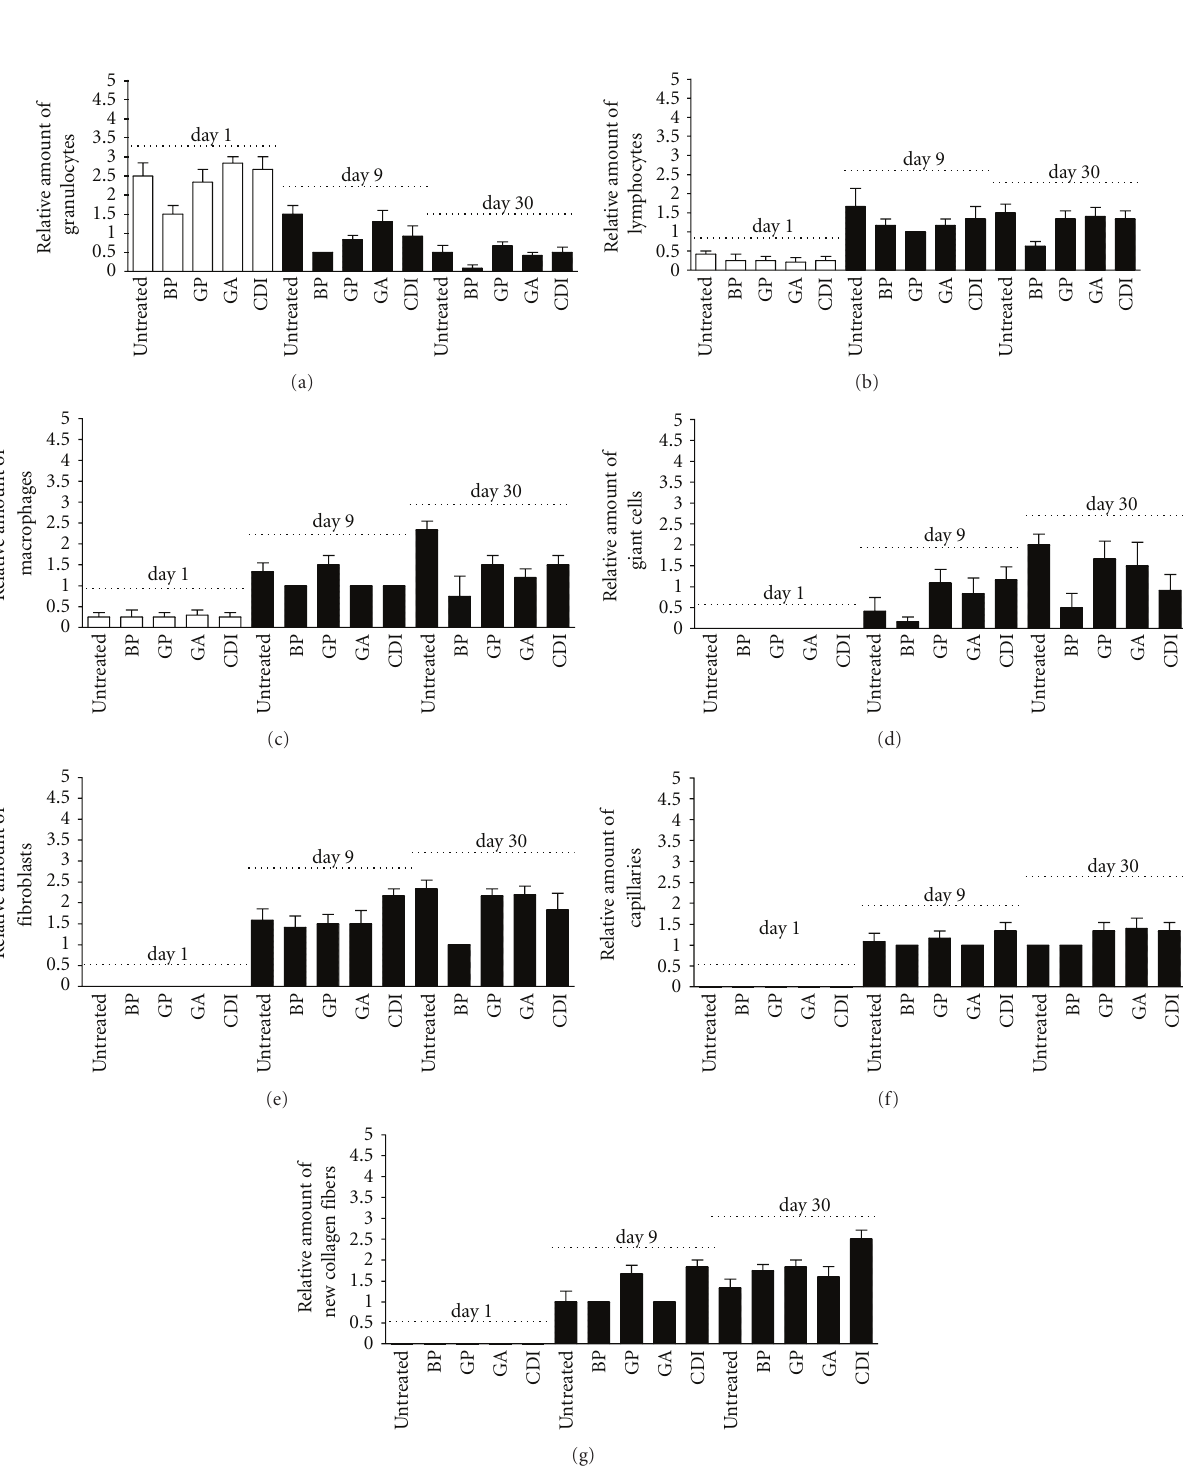
Figure 5: HE-staining analysis of the degree of sca ff old infiltration by granulocytes (a), lymphocytes (b), macrophages (c), giant cells (d), fibroblasts (e), capillaries (f), and collagen fibers (g) after 1, 9, and 30 days. In all implants, an increase of infiltration by lymphocytes, macrophages, giant cells, fibroblasts, capillaries, and collagen fibers could be observed at day 30 compared to day 1 postimplantation. Furthermore, a decrease of infiltrating granulocytes could be observed in all implants at day 30 compared to day 1 postimplantation. Data were calculated based on the scoring by two blinded pathologists ( n = 3 per group and day; one field per slide and rat; each 5 mm 2 ): 1 = 1– 100 cells; 2 ≥ 100–200 cells; 3 ≥ 200 cells. “-”: untreated sca ff old; BP: bovine pericardium (St. Jude, USA); GP: genipin; GA: glutaraldehyde; CDI: carbodiimide. Di ff erences did not reach the level of